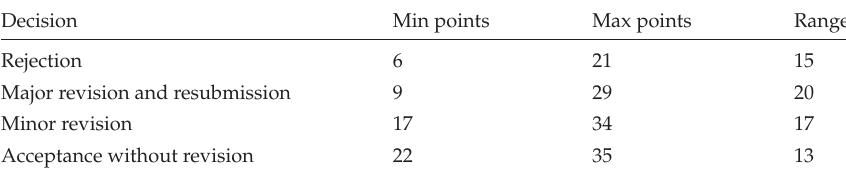
Table 17: Overlapping points and recommendations of the sample.